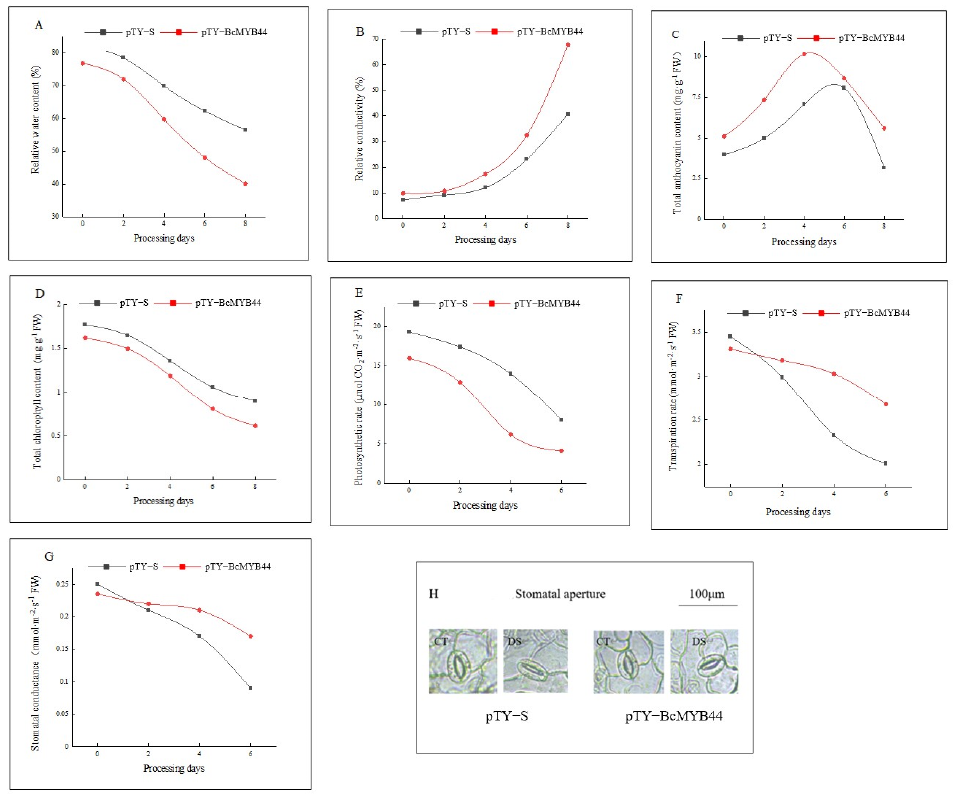
Figure 9. Physiological indexes of non-heading Chinese cabbage under drought stress. They were in order of relative water content ( A ), relative conductivity ( B ), total anthocyanin content ( C ), chlorophyll content ( D ), photosynthetic rate ( E ), transpiration rate ( F ), stomatal conductance ( G ) and stomatal aperture ( H